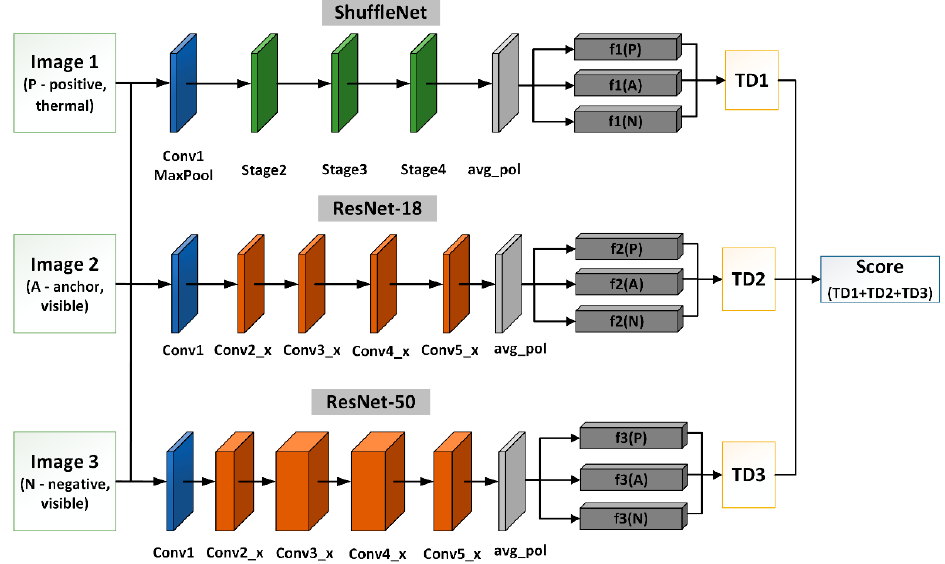
Figure 6. Block diagram of triple triplet architecture.